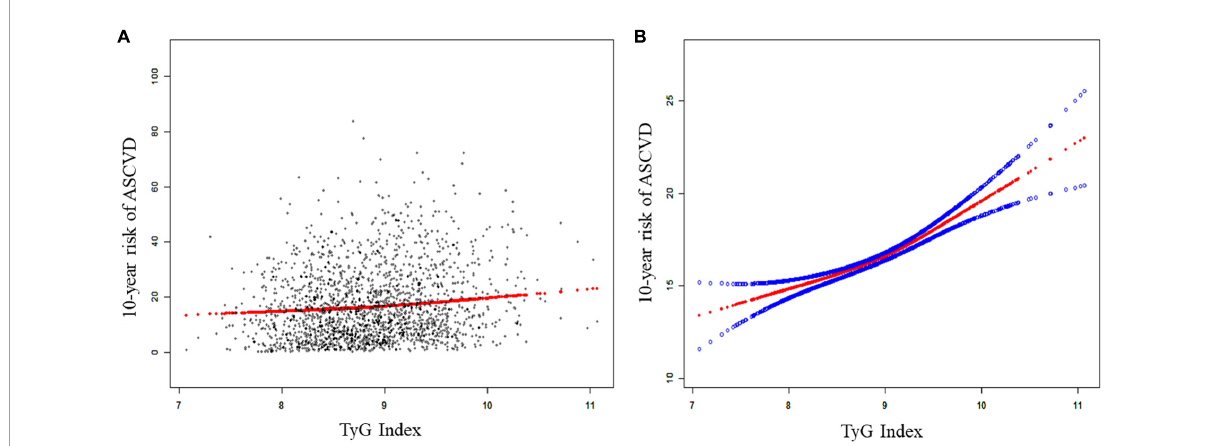
FIGURE1 The association between TyG index and the 10-year risk of a first hard ASCVD event. (A) The linear association between TyG index and the 10-year risk of a first hard ASCVD event. Black points represent samples, the red line represent the fitting line. (B) The smooth curve between TyG index and the 10-year risk of a first hard ASCVD event. Solid red line represents the smooth curve. Blue lines represent the 95% of confidence interval. Age, gender, race, body mass index, systolic blood pressure, diastolic blood pressure, hypertension treatment status, smoking status, diabetes status, and low-density lipoprotein cholesterol were adjusted. ASCVD, atherosclerotic cardiovascular disease; TyG, triglyceride-glucose.